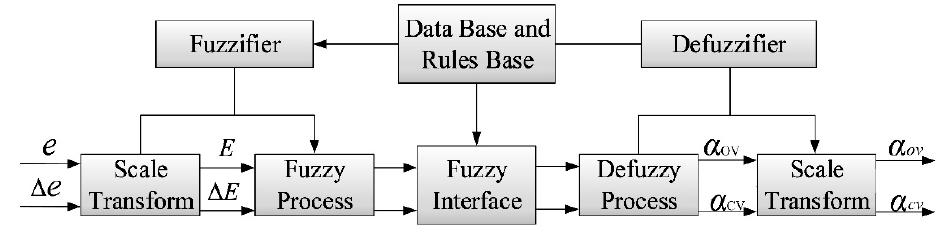
Figure 8. Schematic of fuzzy controller.